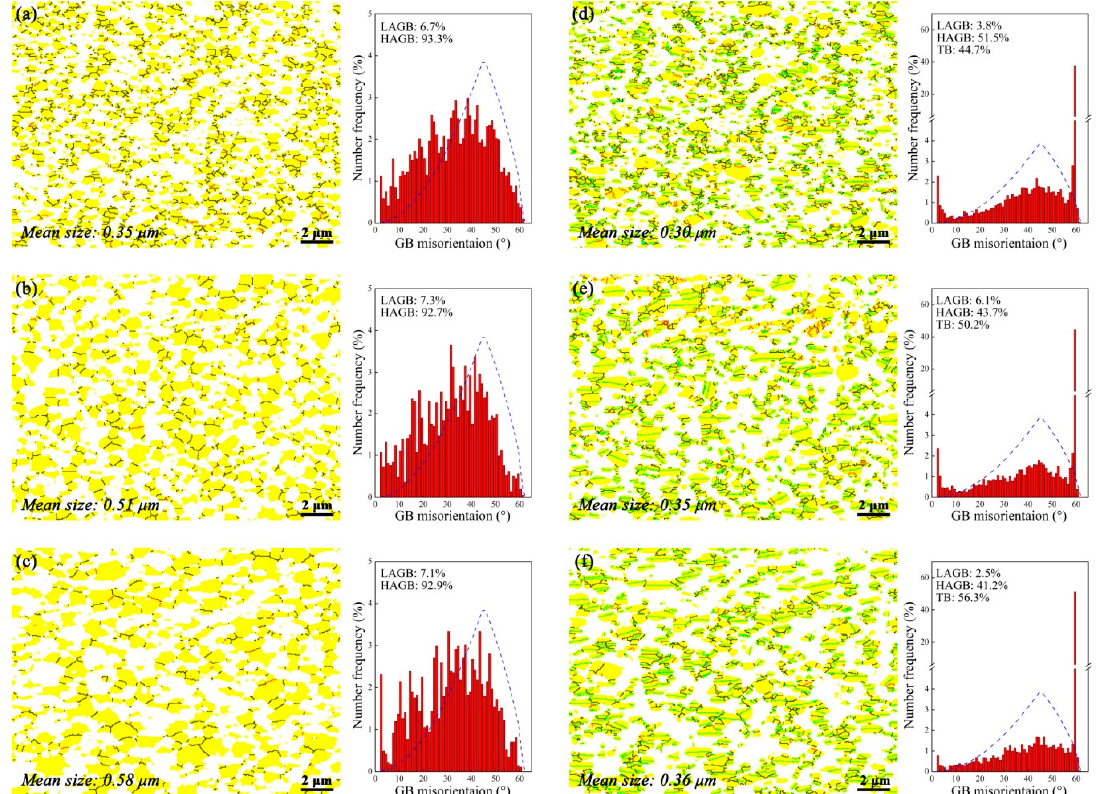
Figure 6. Grain boundary maps and the corresponding grain boundary distribution histogram for ( a – c ) β and ( d – f ) γ phase at ( a , d ) 950 °C; ( b , e ) 1000 °C and ( c , f ) 1050 °C, under a constant strain rate of 0.05 s − 1 . The solid back and red lines denote the high angle grain boundary (HAGB) and low angle grain boundary (LAGB), respectively. The twin boundaries (TB) are in blue. The dash blue lines represent the random distribution of grain boundary distribution. The mean grain size is also tabulated on the maps. The compression axis is vertical.